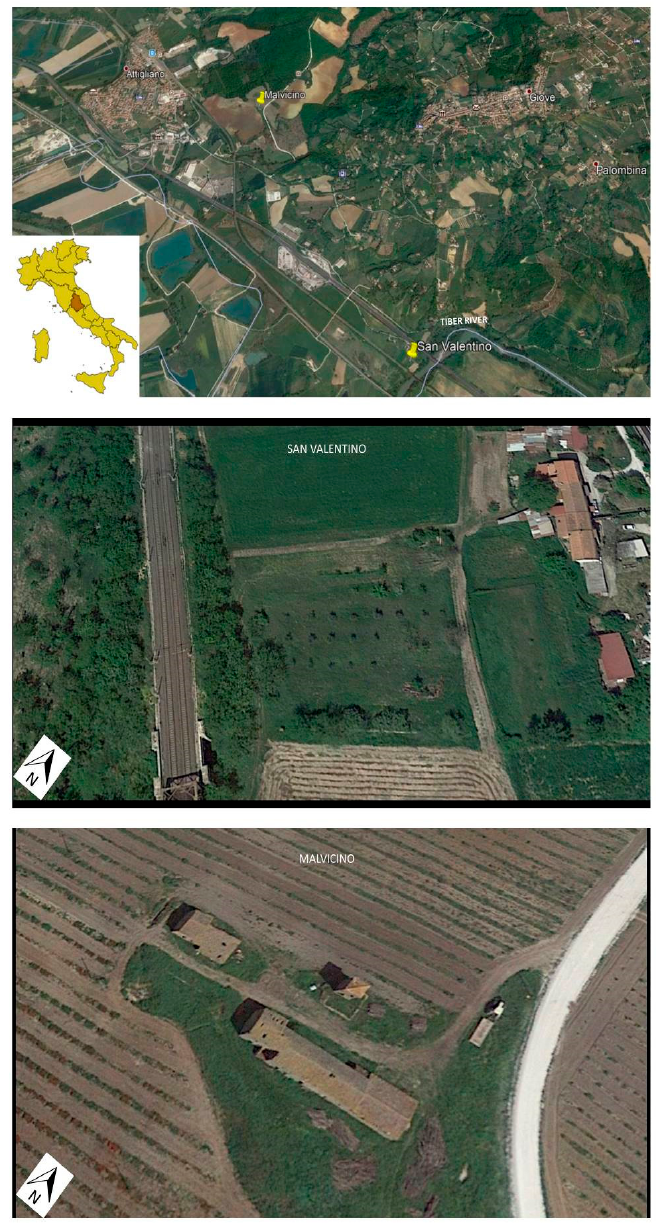
Figure 1. The general location of the two sites (above) and their detailed locations (below).